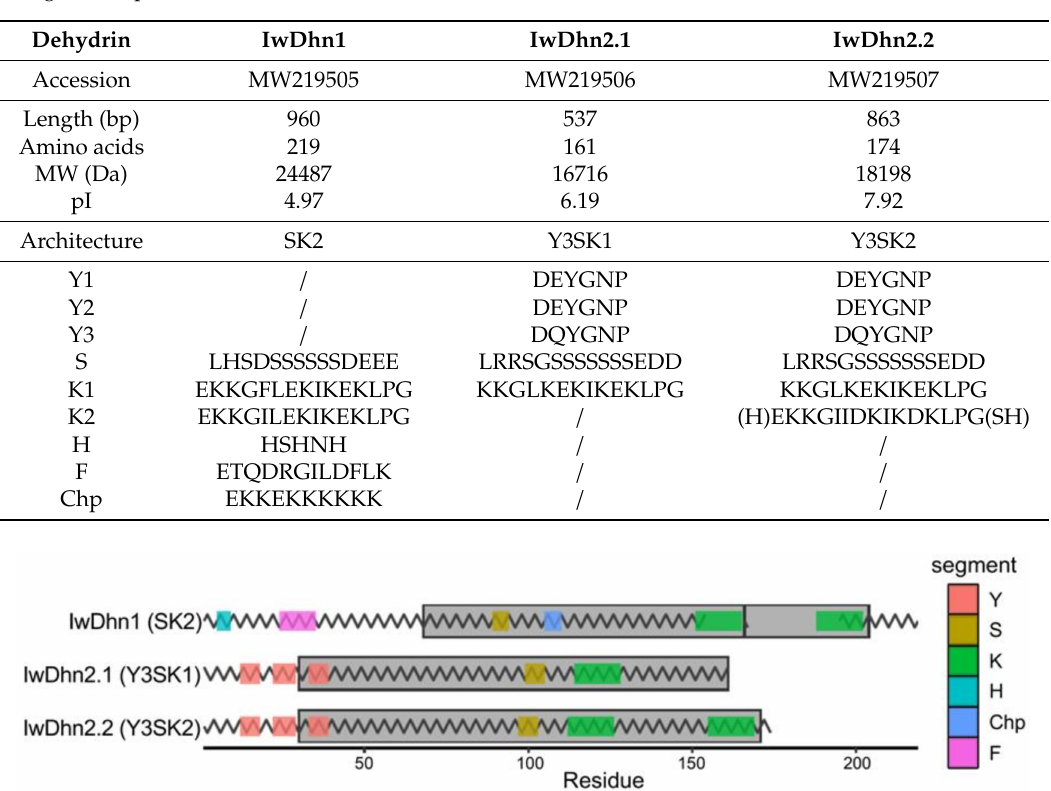
Table 1. Characteristics of dehydrins found in I. walleriana transcriptome. The actual position of each segment is provided in Table S1.